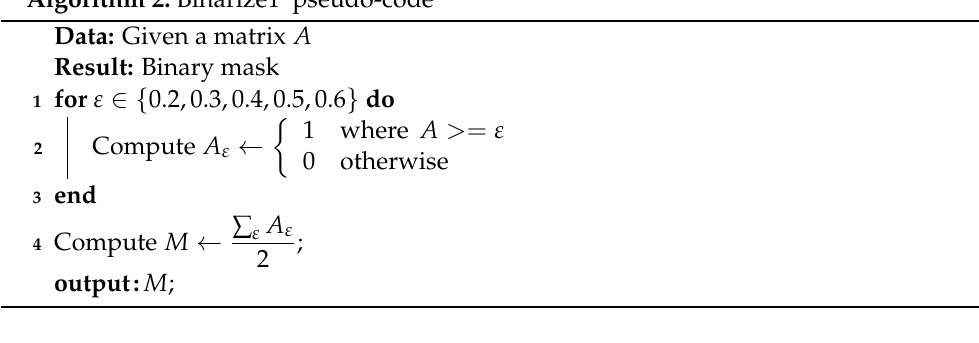
Algorithm 3: Binarize2 pseudo-code